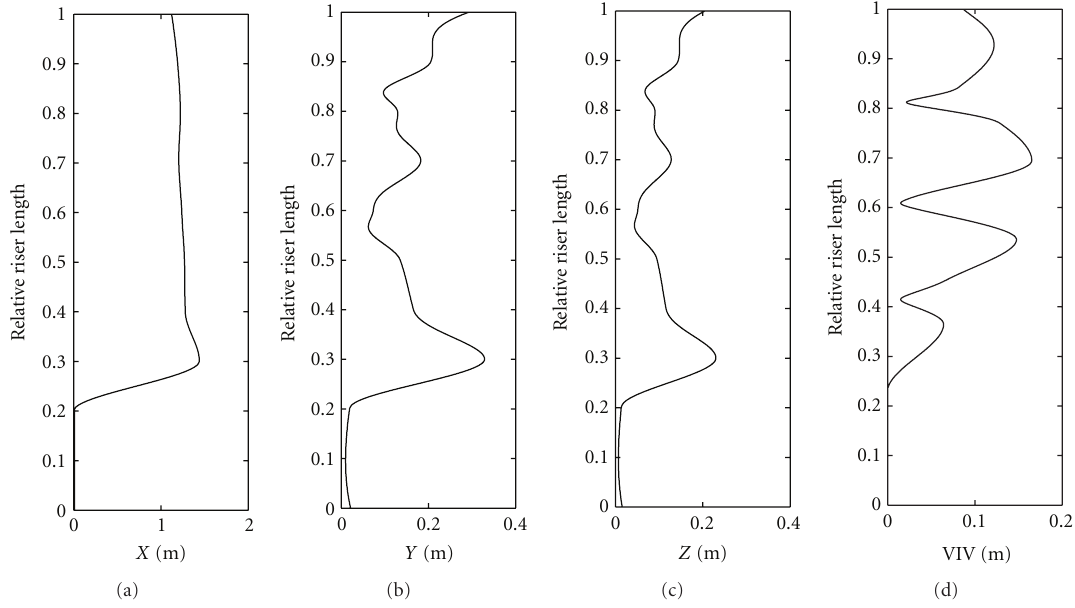
Figure 7: RMS of riser motion in X l , Y l , and Z l directions and VIV perpendicular to the catenary plane.